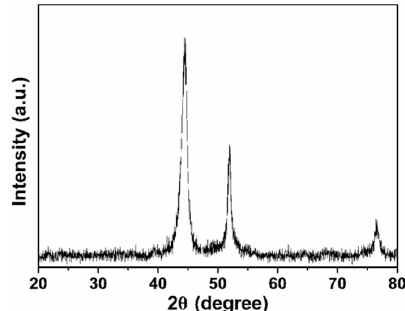
Figure 2. XRD pattern of the NiFe/GO composite.